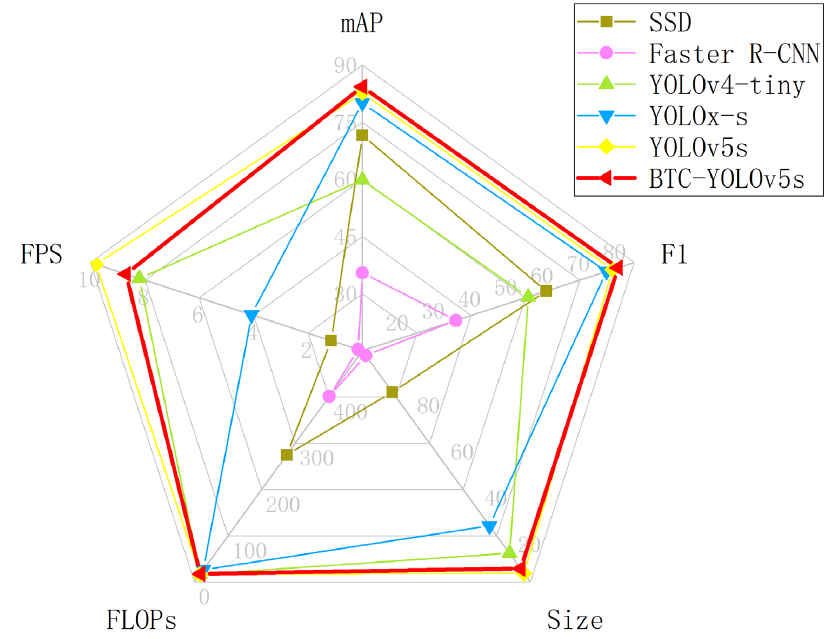
Figure 11. Performance comparison of different detection algorithms.